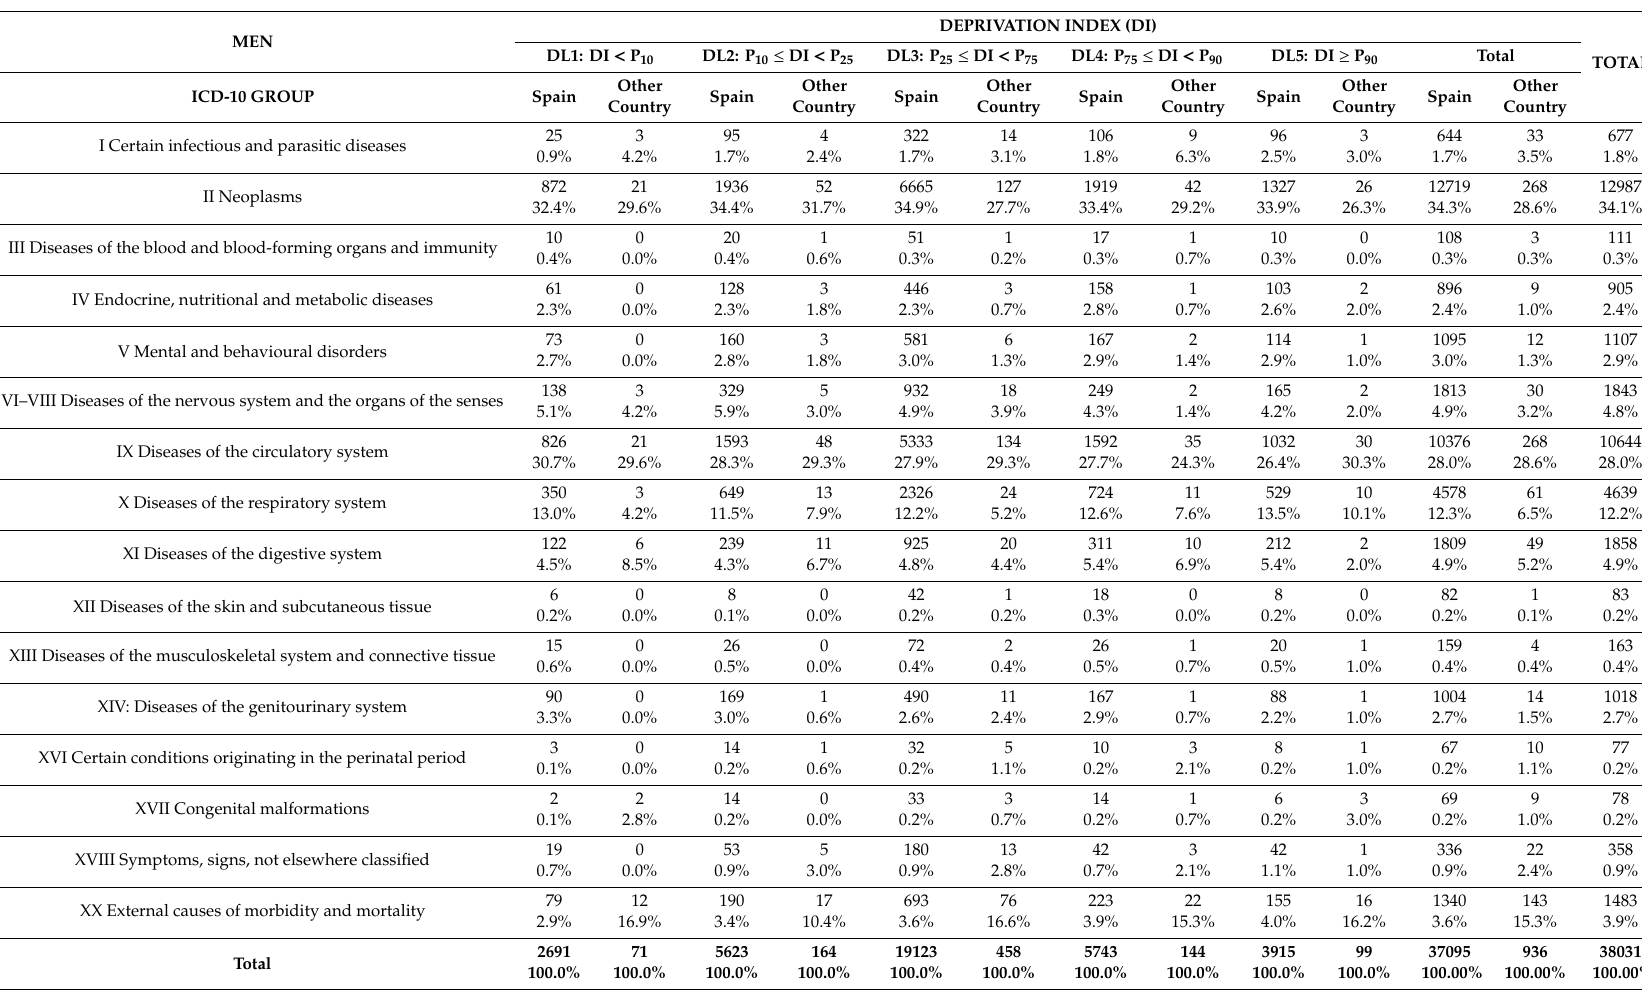
Table 3. Frequencies and percentages of death according to large groups diseases of the ICD-10, by sex, level of deprivation and country of birth, for the three cities.